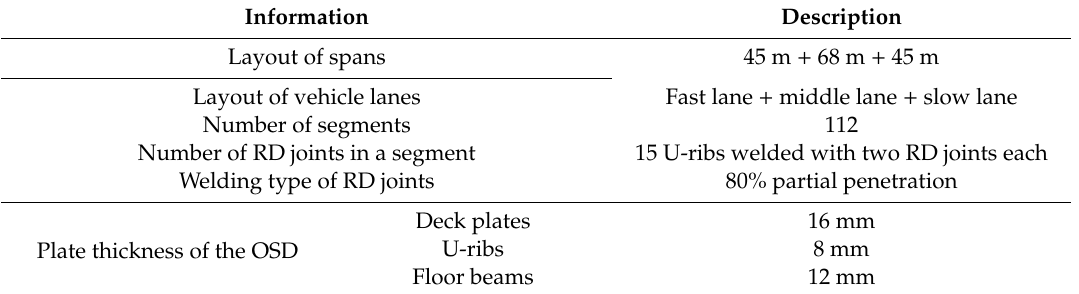
Table 1. Basic information about the prototype